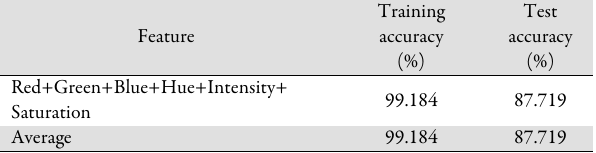
Table 7. Accuracy values using six colour features